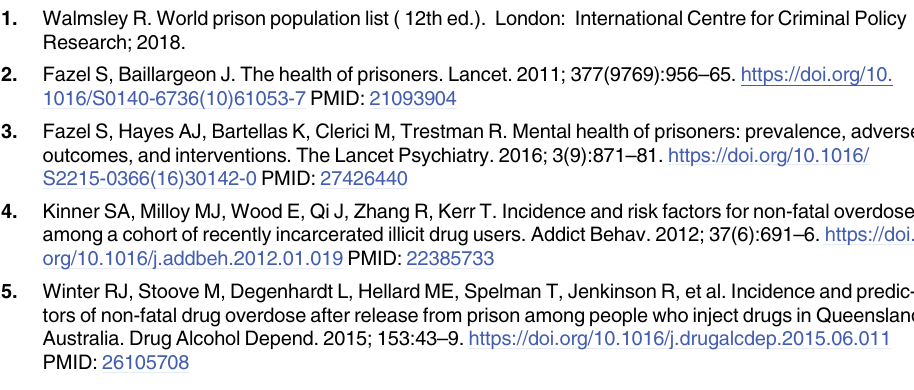
S6 Table. Effect of behavioural health services on hazard of re-incarceration by timing of service initiation (N = 1,115). S7 Table. Effect of behavioural health services on hazard of re-incarceration by frequency of service contacts (N = 1,115). S8 Table. Effect of mental health and substance use services on hazard of re-incarceration, restricted to the control arm of the Passports intervention. S1 Text. Detailed methods for Model 3: Estimation of inverse probability of